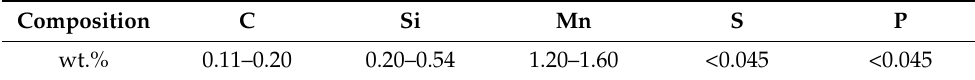
Table 1. Chemical compositions (wt.%) of Q345 stainless